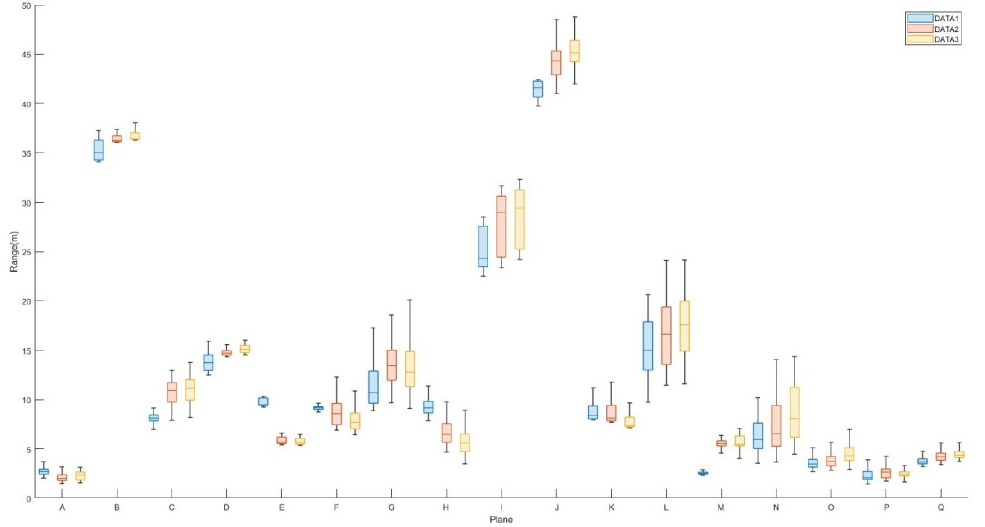
Figure 17. Box diagram of calculated pseudoranging measurements in each plane after subsampling and blunder removal by the RANSAC algorithm for datasets DATA1, DATA2, and DATA3.